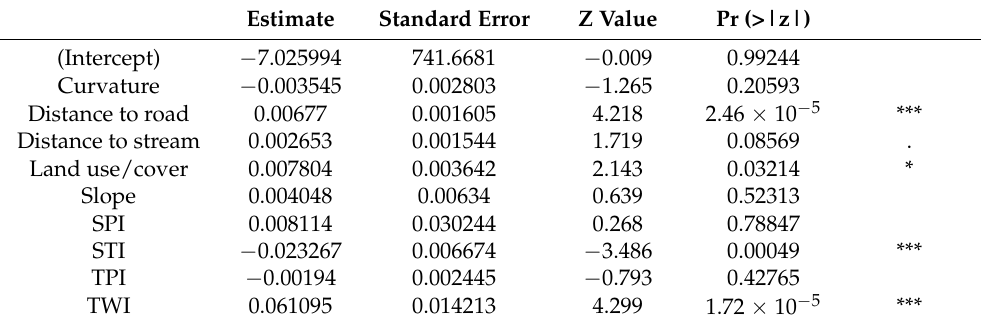
Table 4. Significance levels of the conditioning